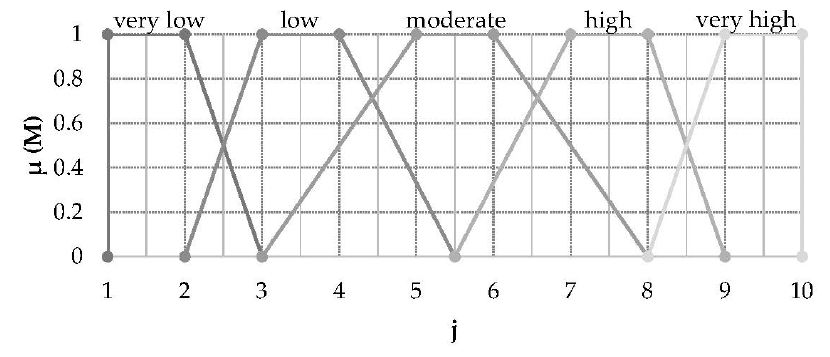
Figure 2. Fuzzy sets.